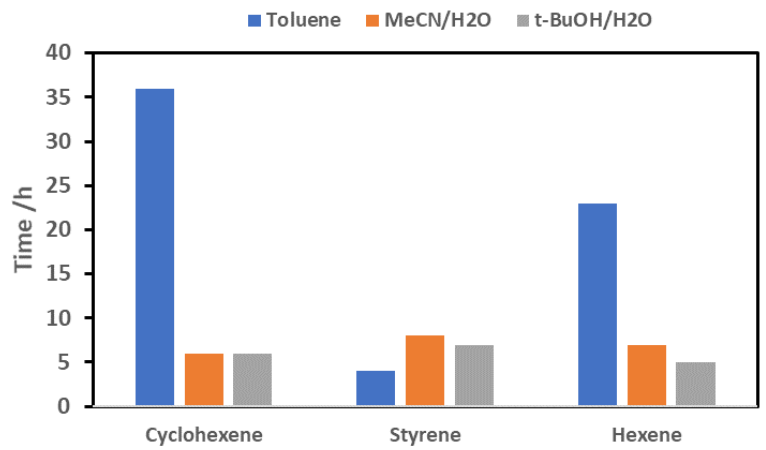
Figure 3. Effect of the solvent system on the reaction time for 99.99% conversion of the olefin determined by gas chromatograph (GC), using chloramine-T as the nitrogen source and catalyst A at 60 °C.